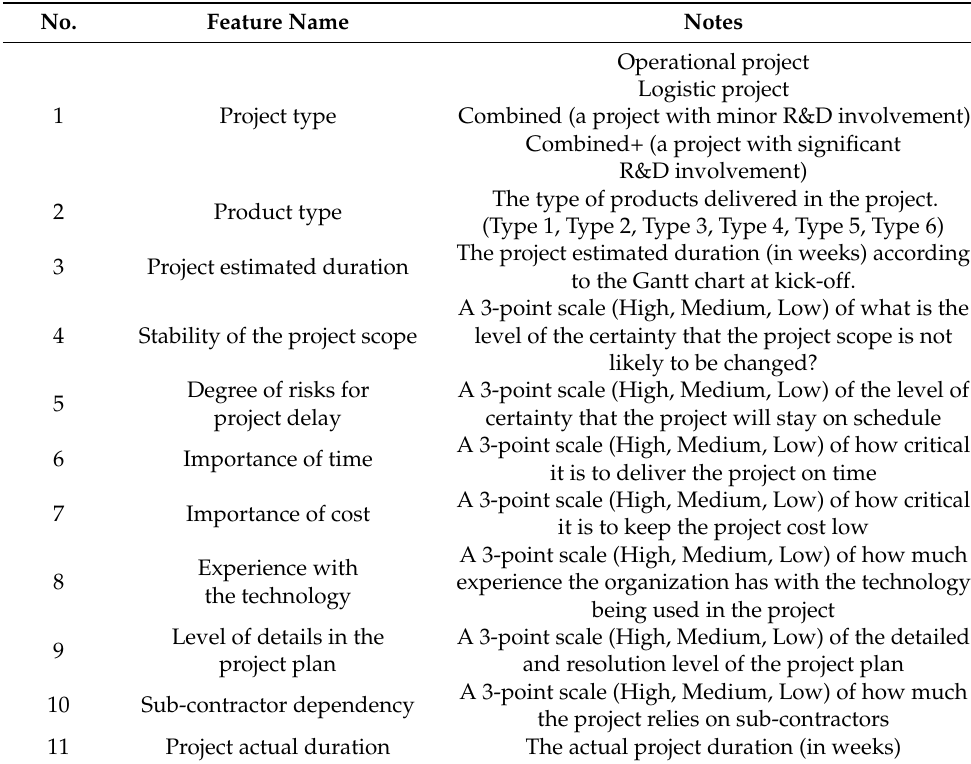
Table 2. Project Features of Organization